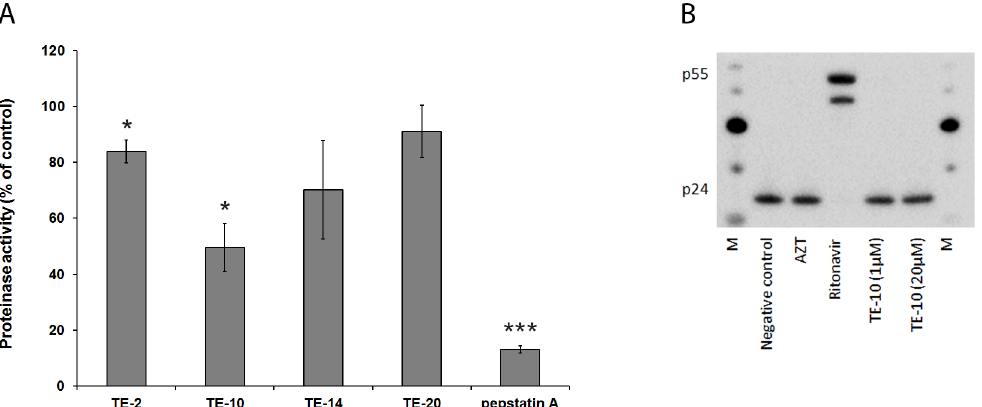
Fig 8. Inhibition of HIV-1 protease. (A) Inhibition of HIV-1 protease activity: The HIV-1 protease (100 ng/well) and the compounds (25 μ M concentration) or an inhibitor control (pepstatin A) were added to a flat-bottom 96-well plate. The plate was incubated for 15 minutes at 37°C and the provided protease substrate was added to all wells. The fluorescence was measured at Ex/Em = 490 nm/520 nm. The value for the vehicle control was set to 100% in each individual experiment and all other values were normalised to this reference value. The data are means of three independent experiments; the error bars represent the SEM. P-values are indicated if significant ( * : p < 0.05; ** : p < 0.01; *** : p < 0.001).(B) Inhibition of HIV-1 protease activity in viral particles: Persistently infected HuT-78/HIV-1 cells were incubated in the presence or absence of compound (3.7 μ M AZT, 2.8 μ M ritonavir or 1 μ M/20 μ M TE-10). After 43 h, virus particles in the cellular supernatants were harvested, lysed and subjected to Western blotting. P24 and its precursor p55 were detected using an anti-p24 antibody. Negative control: no compound added during incubation. M: MagicMark XP Western Protein